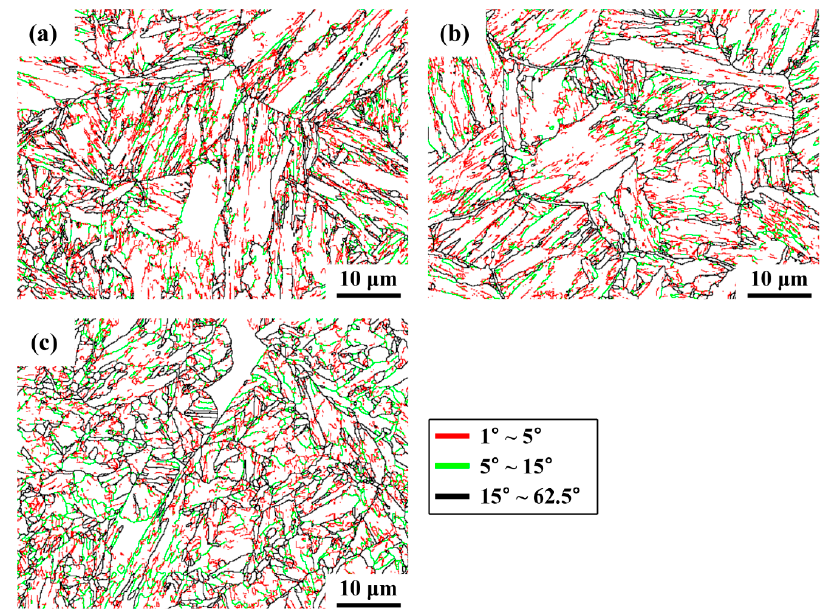
Figure 5. Grain boundary maps of the ( a ) WT, ( b ) WT-820T and ( c ) WT-890T samples.